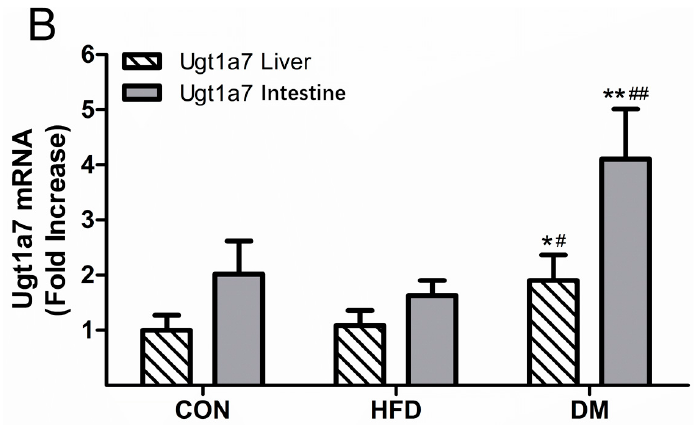
Figure 4. Messenger RNA (mRNA) expression levels of Ugt1a1 ( A ) and Ugt1a7 ( B ) in the liver and intestines of DM, HFD, and CON rats. Data represent the mean ± SD, n = 7 rats, * p <0.05, ** p <0.01 in DM versus CON rats; # p <0.05, ## p <0.01 in DM versus HFD rats.